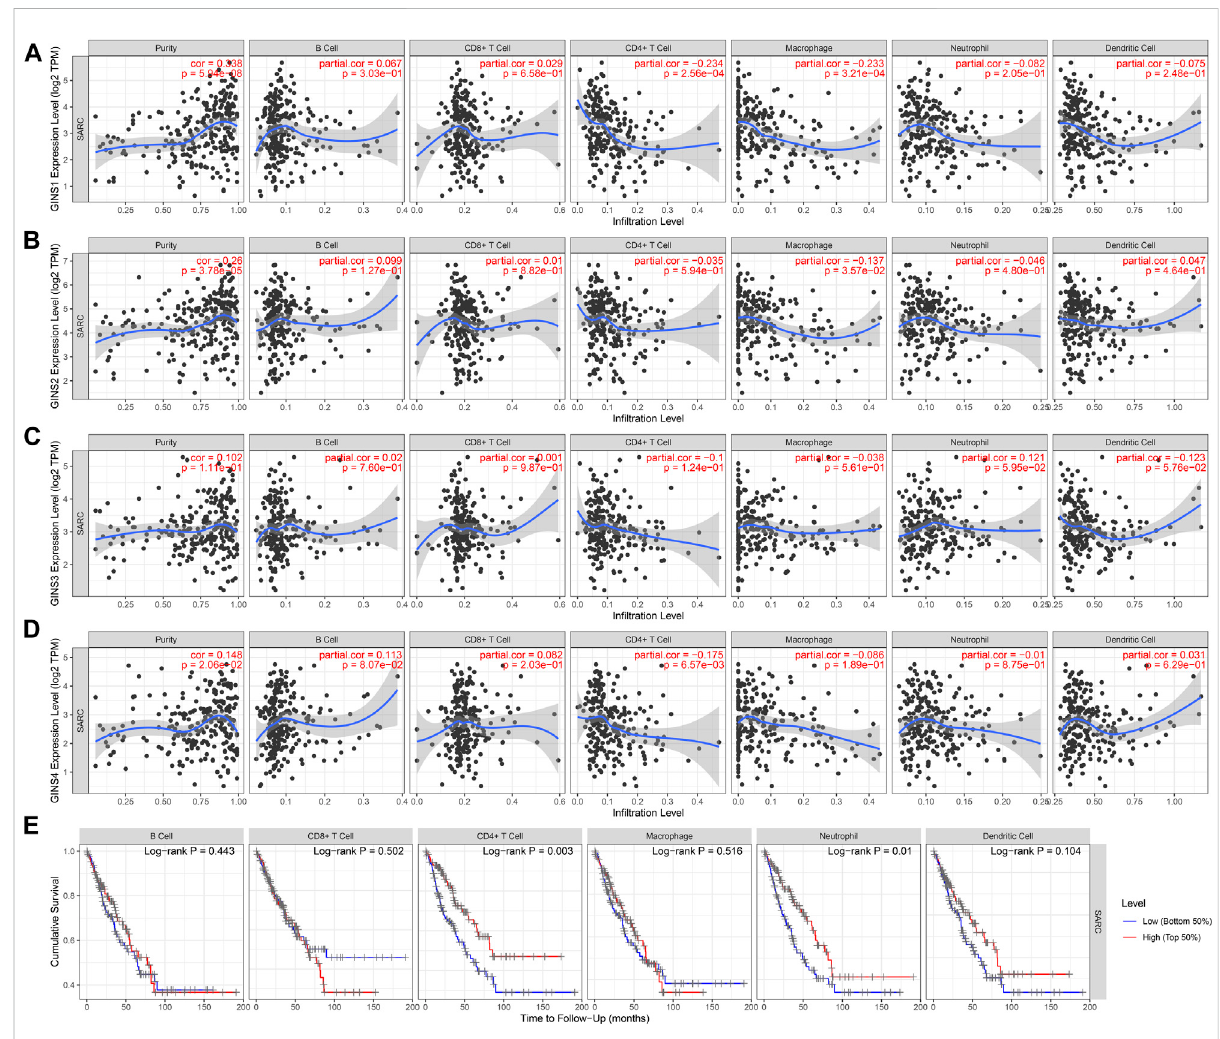
FIGURE 13 Correlation of immune in fi ltration level with GINS1/2/3/4 expression in SARC (A – D) . Meanwhile, high CD4+ T cell and neutrophil in fi ltration levels were associated with better survival outcomes in SARC (E)